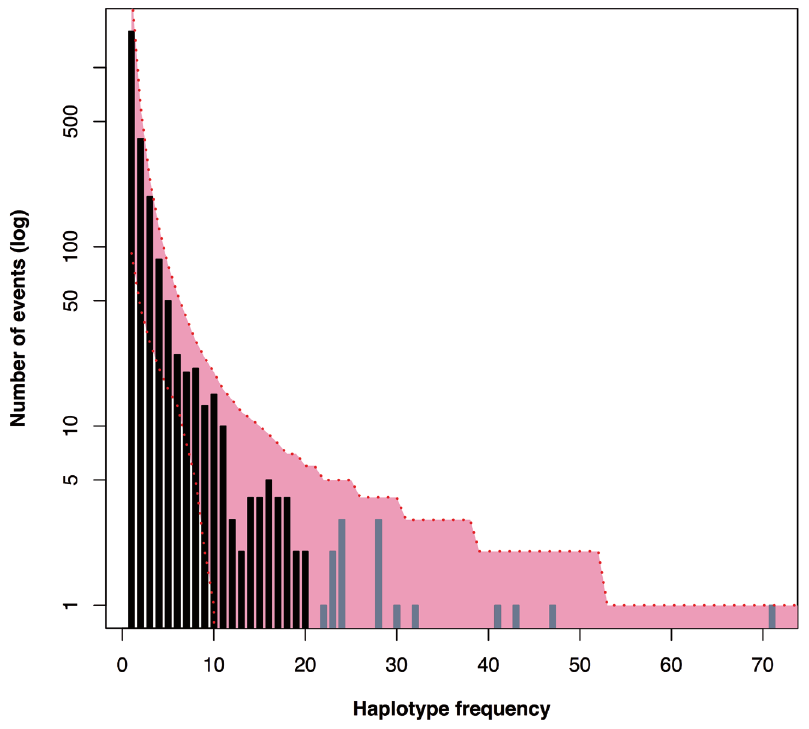
Figure 1. Microsatellite haplotype frequency distribution. The distribution (black and grey bars) is identical to Figure 2 of Balaresque et al. 4 . Grey bars indicate the 15 haplotypes that Balaresque and colleagues describe as ‘unusually frequent.’ Red shading indicates the 95% confidence intervals of haplotype frequencies from one million simulations under a fitted neutral model. All of the high frequency haplotypes (grey bars) fall within these 95% confidence